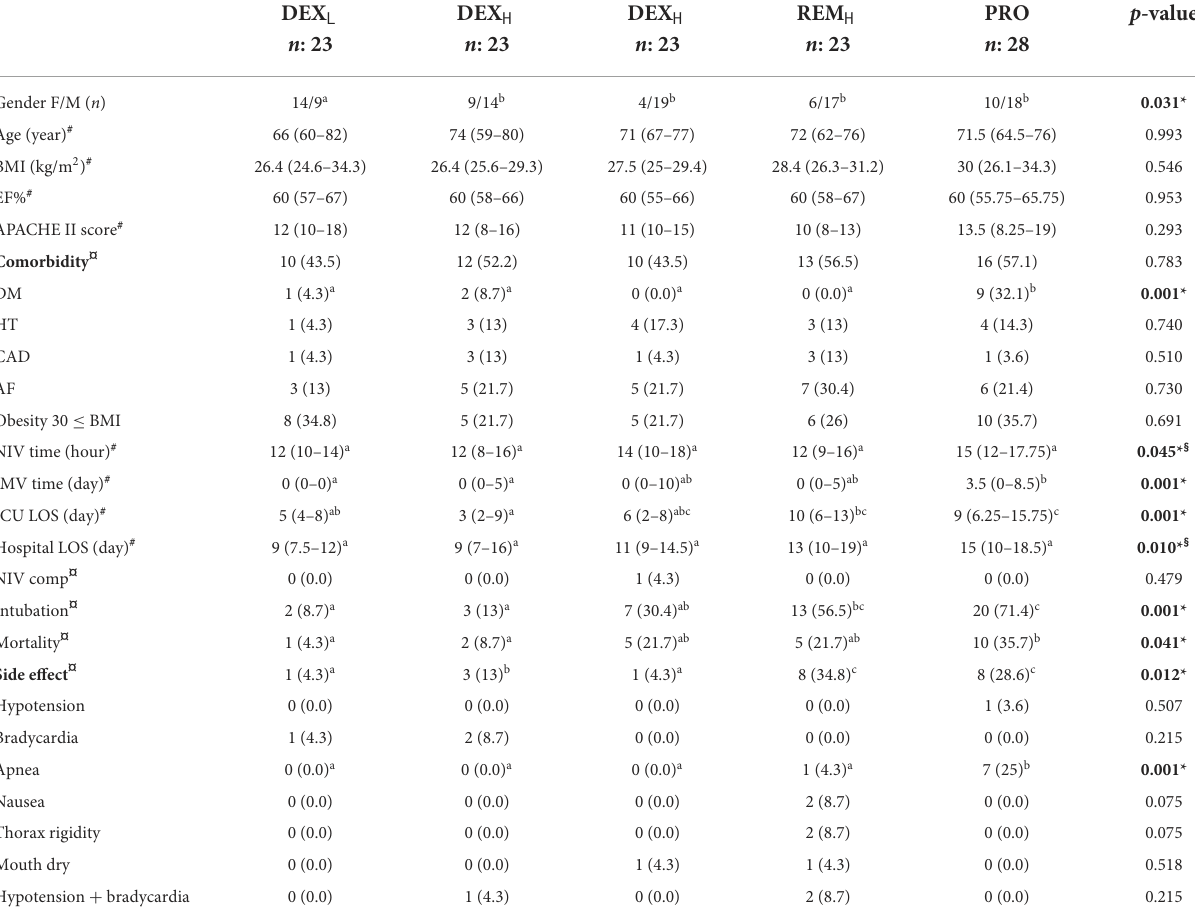
TABLE 3 Baseline characteristics of the groups and data on clinical